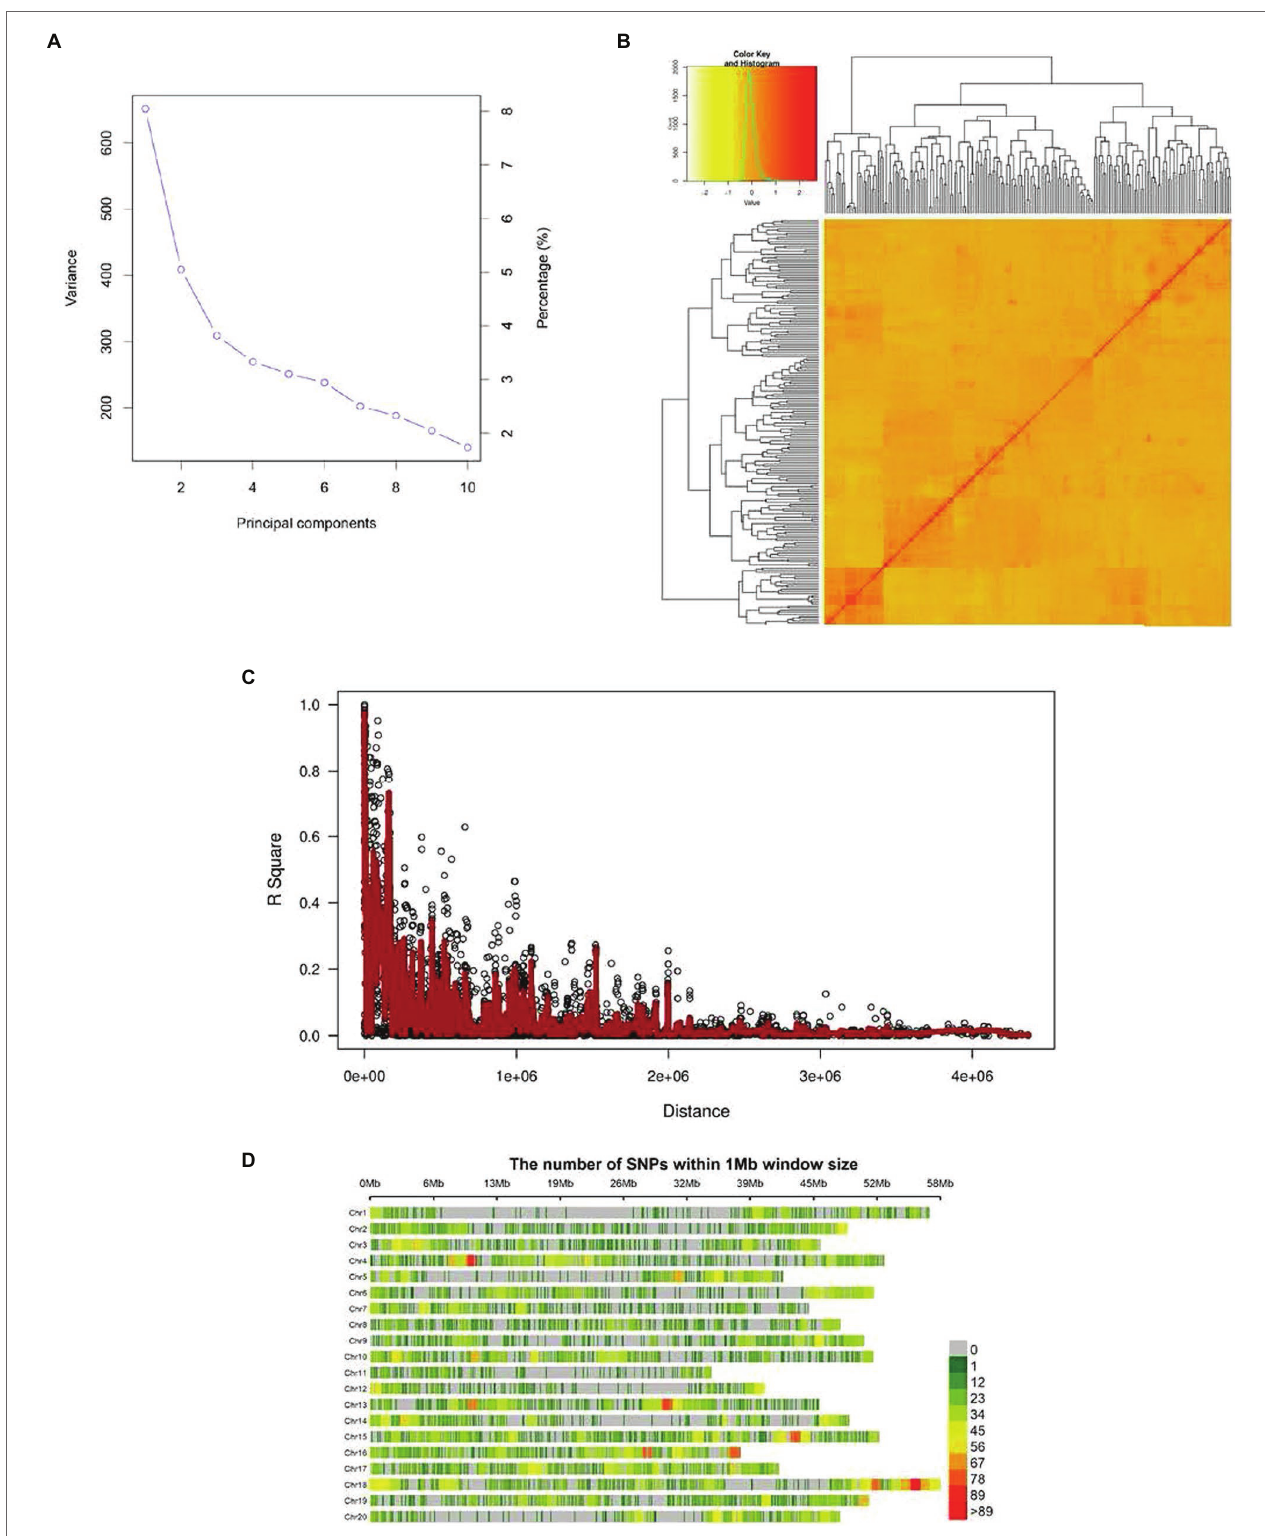
FIGURE 1 | (A) PCA (Scree plot) plot depicting the population structure of the 200 soybean genotypes, (B) the heat map of the kinship matrix pf 200 soybean genotypes of the current GWAS, (C) the genome-wide average LD decay ( R 2 ) of the GWAS panel, and (D) genome-wide SNP coverage showing the number of SNPs within 1 Mb window size. Chromosomes appear horizontally with the density of SNPs depicted in the scale shown to the